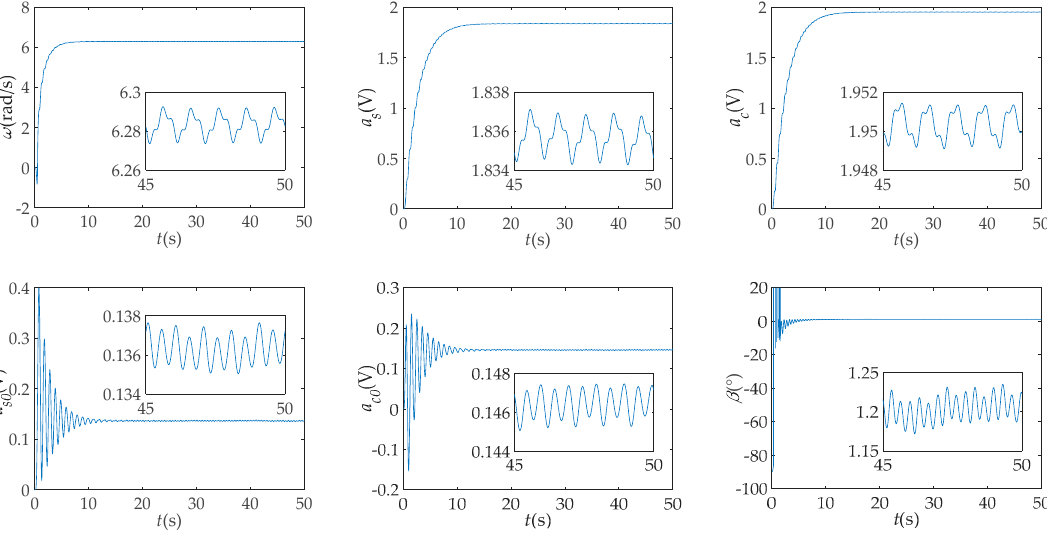
Figure 8. Estimations of angular velocity and imperfect parameters in simulation after the Butterworth filter (Group 2).